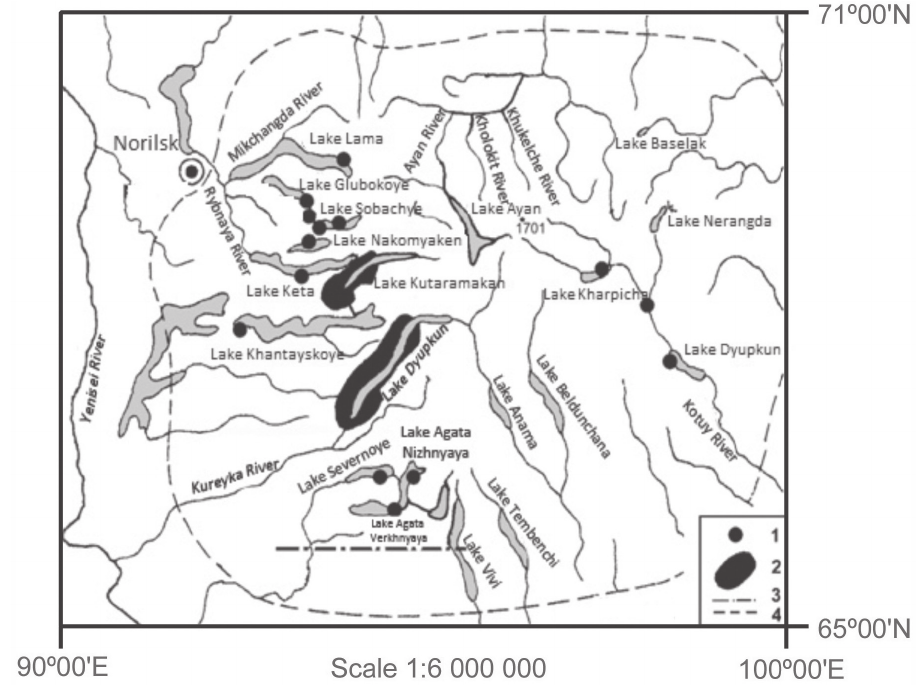
Figure 2. Distribution of Anser erythropus during the nesting period on Putorana Plateau. 1 meet- ing points of territorial pairs, litters and non-breeding individuals 2 long-term successful nesting areas 3 southern boundary of breeding range; 4: Putorana Plateau